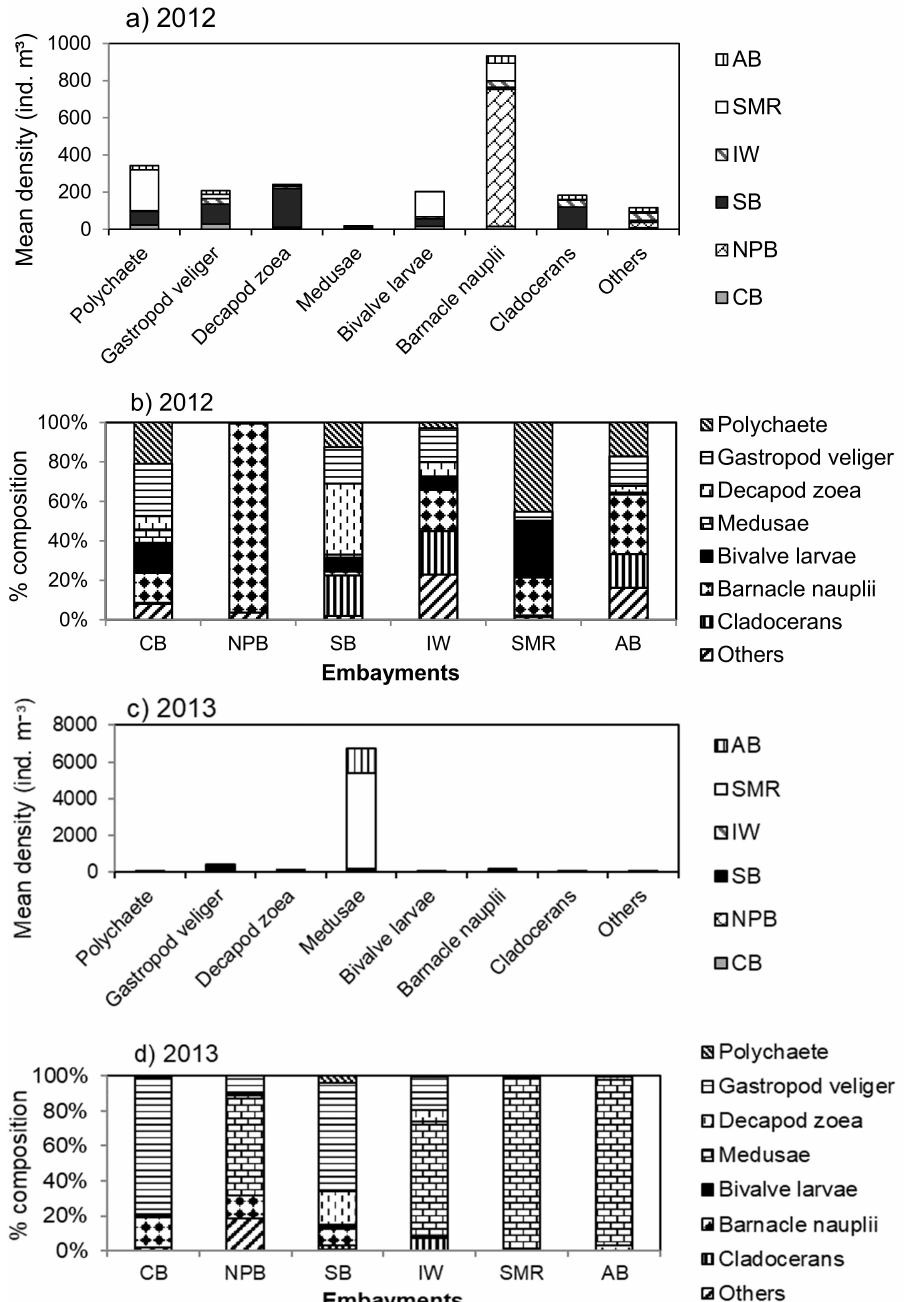
Figure 7. Spatial distribution, abundance ( a , c ) and percentage composition ( b , d ) of non-copepod mesozooplankton in the MCBs during 2012 (below average) and 2013 (above average) freshwater discharge from winter to summer. CB, Chincoteague Bay; NB, Newport Bay; SB, Sinepuxent Bay; IWB, Isle of Wight Bay; SMR, St. Martin River; AB, Assawoman